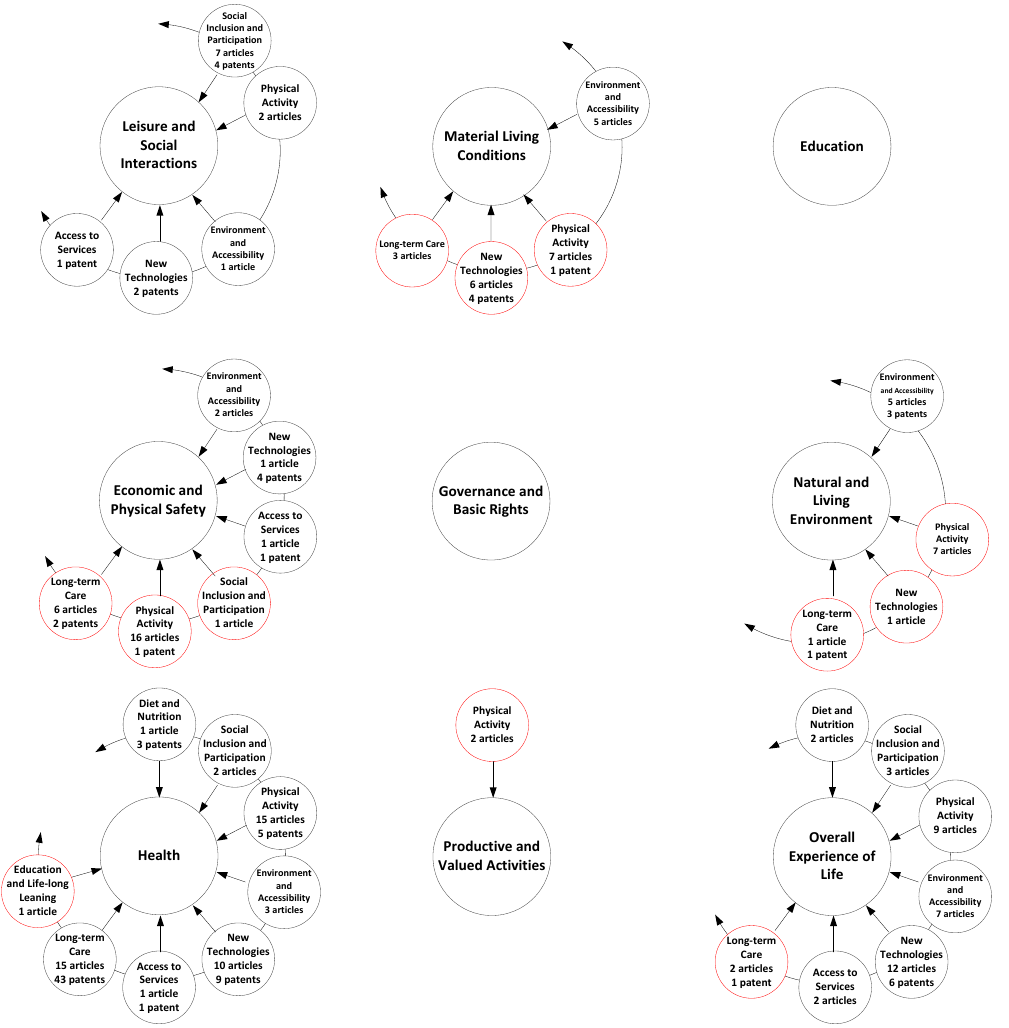
Figure 5. A superimposition of the results of the literature and patent review in terms of smart determinants to QoL dimensions show the gaps where scientific and R&D focus can be placed in the future, and where there is still room for scientific findings to be translated into potential patents. Newly added circles in red and omitted circles from the circle spoke diagram denote deviations from the proposed mapping.